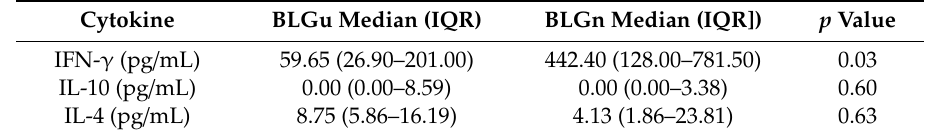
Cytokine levels after BLGu and BLGn stimulation were compared by Mann–Whitney-U - test. IFN- γ was significantly enhanced by stimulation of BLGn compared to BLGu. BLG, beta-lactoglobulin; BLGn, nitrated BLG; BLGu, untreated BLG; IQR, interquartile